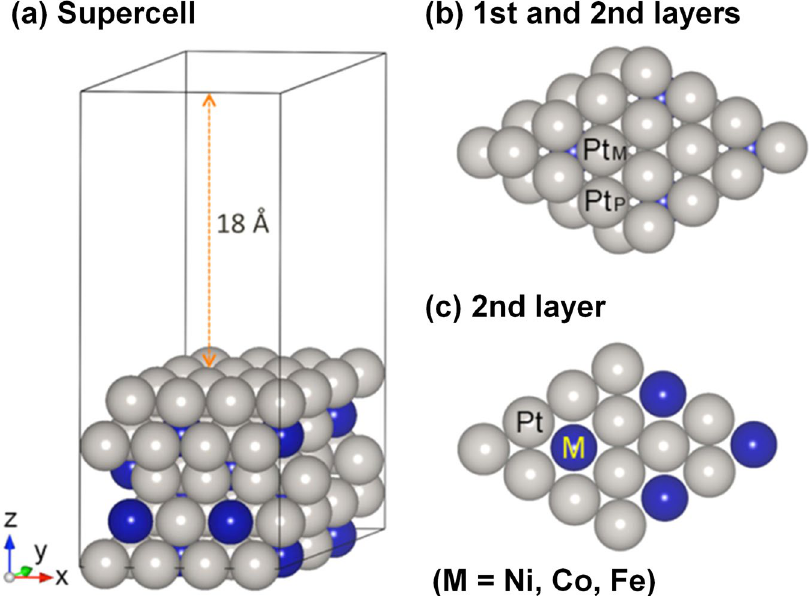
Figure 4. Model structure for the DFT calculation. ( a ) Supercell structure. ( b ) Top view of the supercell showing the first and second layers. ( c ) Top view of the second layer.